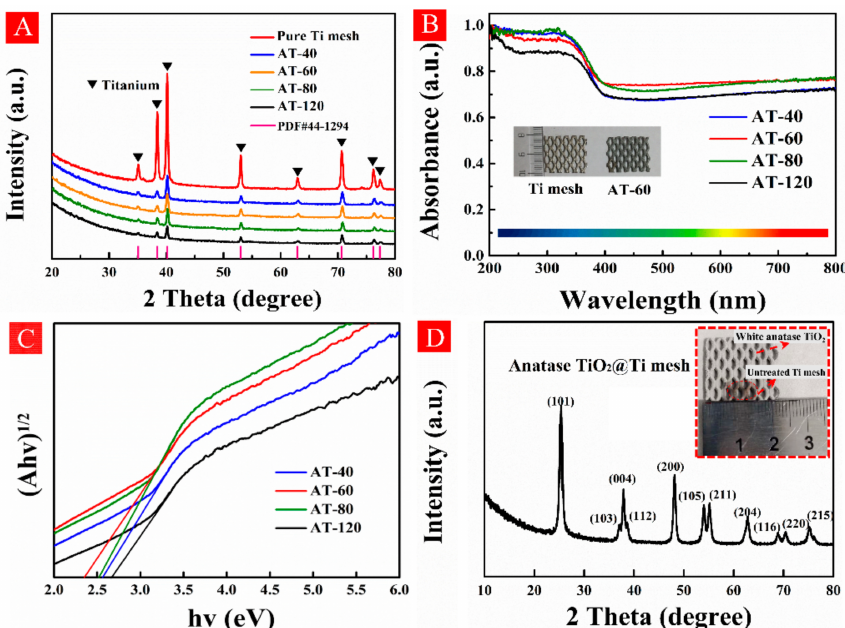
Figure 2. ( A ) X-ray diffraction (XRD) patterns and ( B ) diffuse reflectance spectroscopy of untreated Ti mesh and all samples. ( C ) the plots ( α h ν ) 1/2 versus h ν by using the Kubelka–Munk function. ( D ) the XRD pattern of AT-60 sample after annealing treatments, and its color changed from gray to white